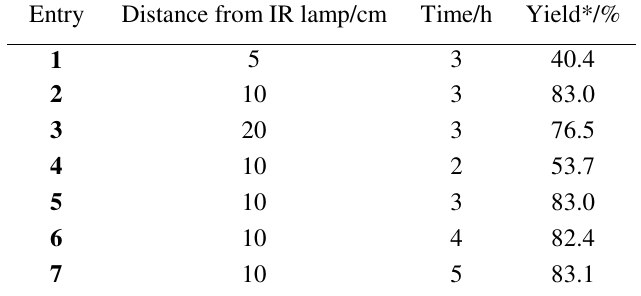
Table 1. The Effects of the Reaction Conditions on the Yield of Substituted 5-Oxo-1, 2, 3, 4, 5, 6, 7, 8-Octahydroquinoline Derivatives